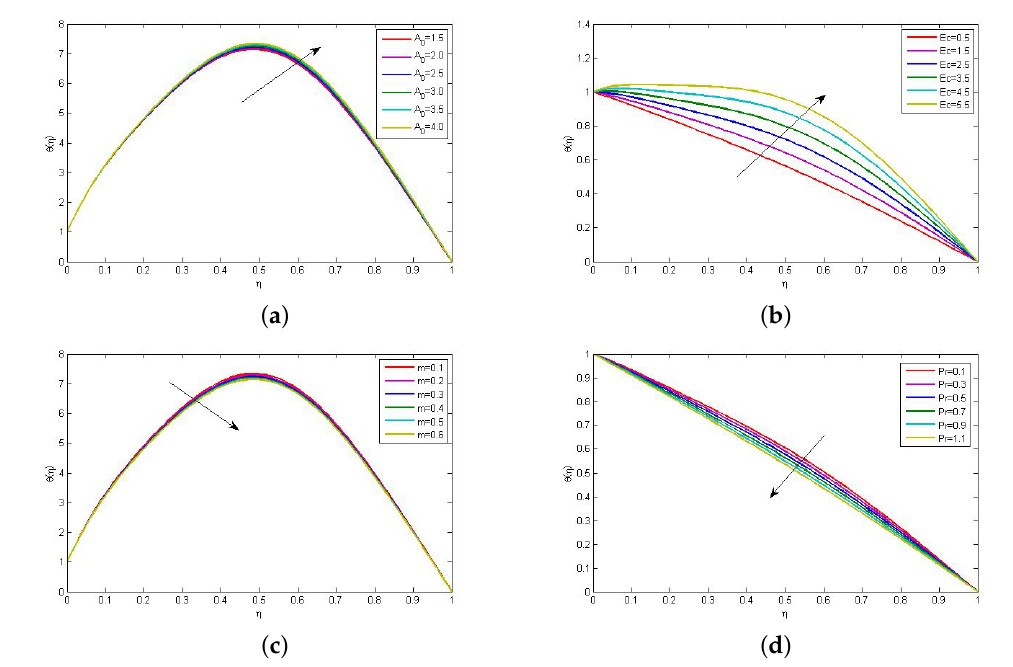
Figure 7. ( a ) Influence of A 0 , ( b ) Sc on , ( c ) m , and ( d ) Pr on θ ( η ) .